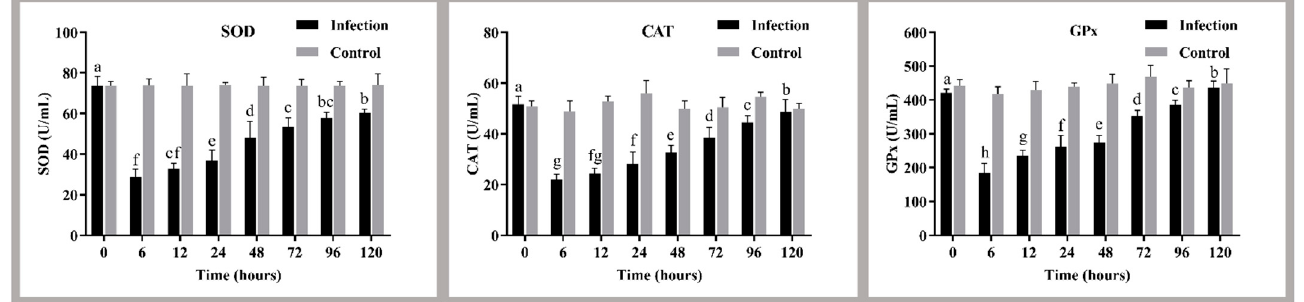
Figure 3. The liver antioxidant capacity of golden pompano before and after the challenge. Different letters indicate significant differences between the stress groups ( p < 0.05). The values are the means ± SEs ( n = 3). The grey bars represent the indicators of fish before the challenge, and the black bars represent the indicators of fish after the challenge. SOD, superoxide dismutase; CAT, catalase; GPx, glutathione peroxidase.